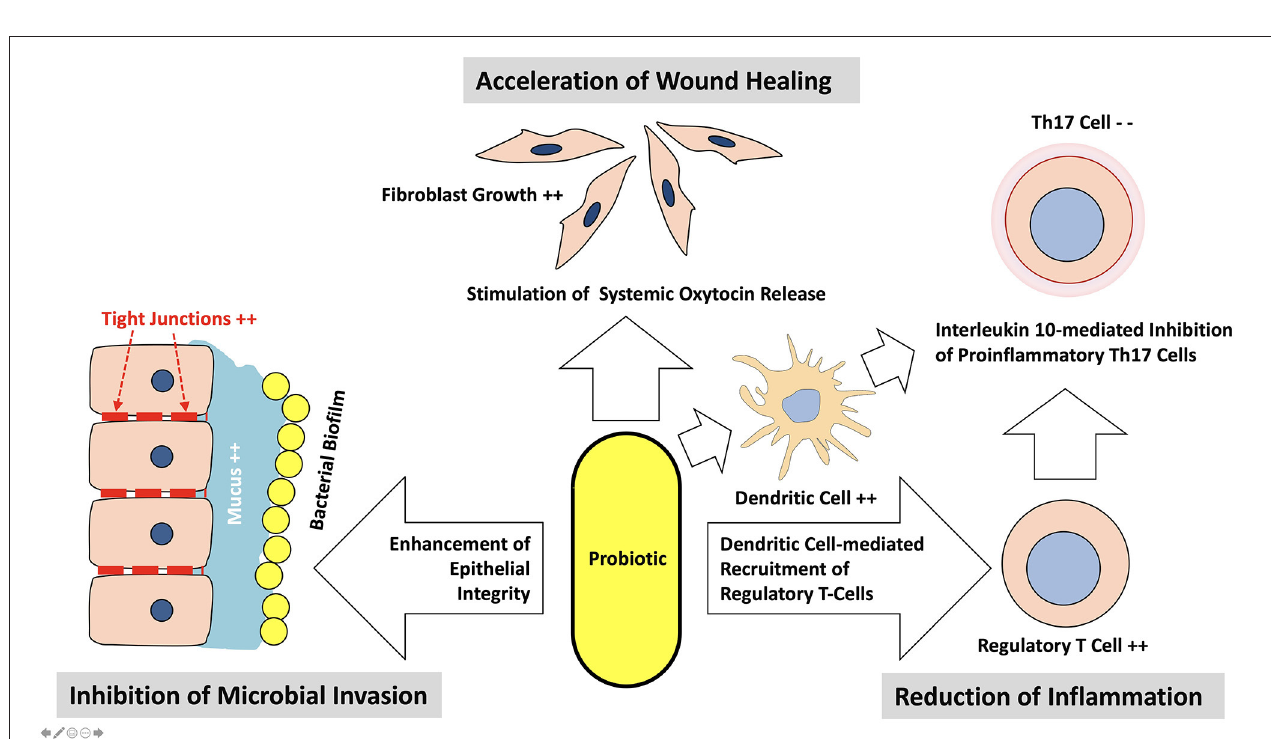
FIGURE 2 | Mechanisms used by probiotics to interfere with their host locally and on a systemic